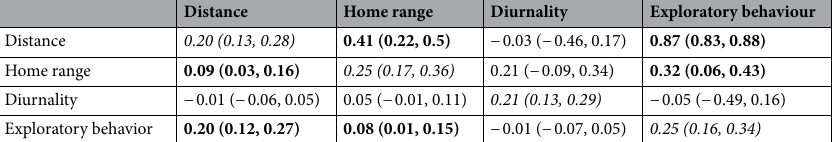
Table 2. Among-individual variance–covariance matrix for movement behaviors at the monthly level. Among-individual variances (V I, analogous to repeatability over the full range of behavioral measurements) are given on the italicised diagonal (top-left to bottom-right), with among-individual between-trait covariances (COV I ) below and the corresponding correlations ( r I ) above. 95% credible intervals are provided in parentheses and bolded numbers highlight between-trait covariances and correlations that do not overlap